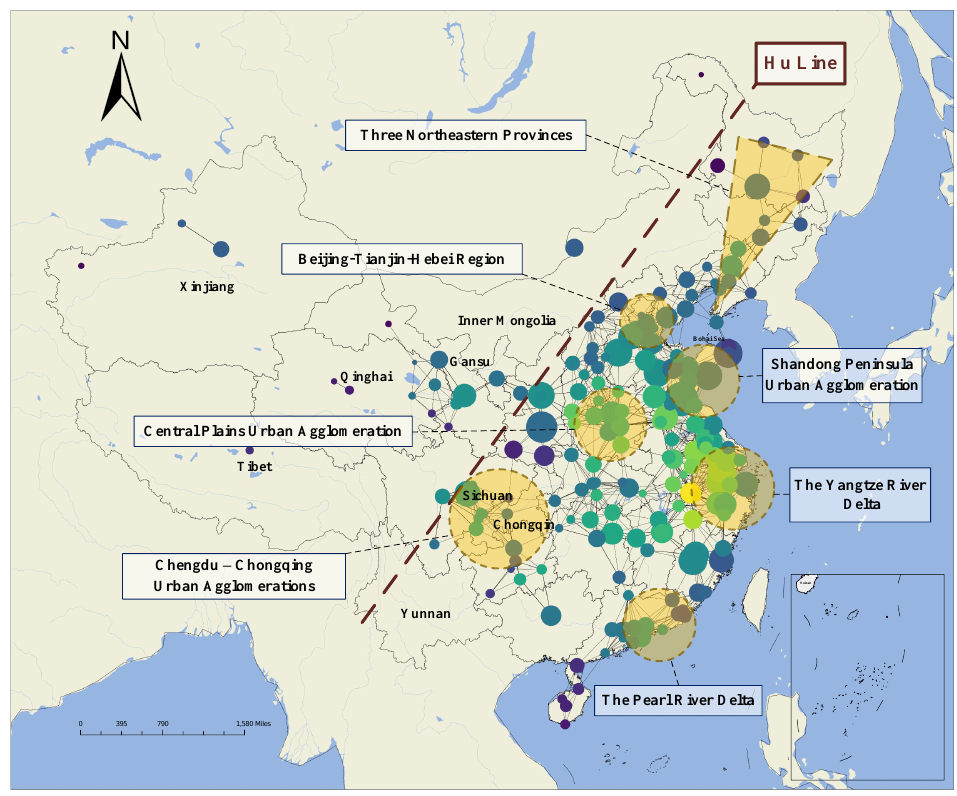
Figure 2. Distribution of social organizations in